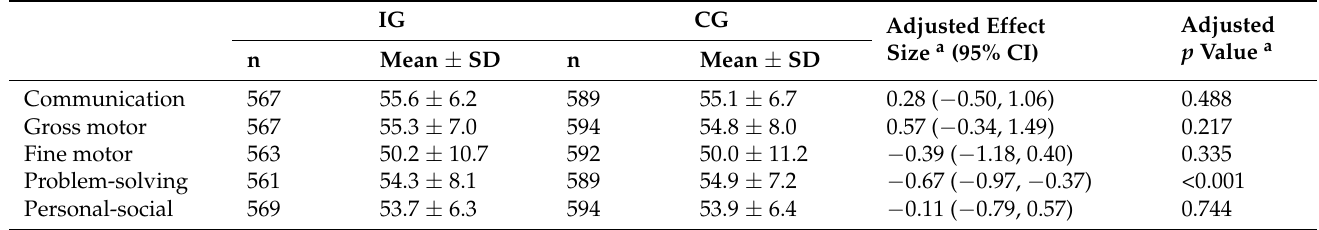
Table 3. Child neurodevelopment assessed by ASQ scores in the five domains at 3 years of age.